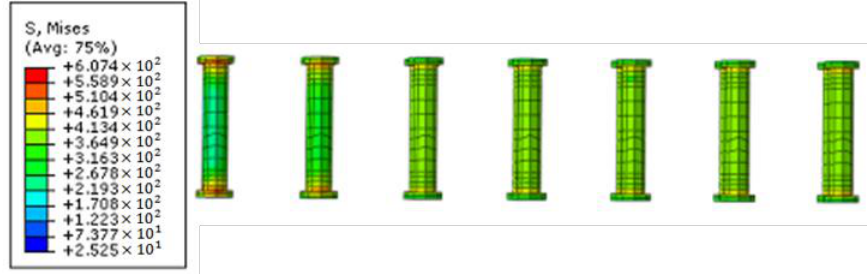
Figure 18. Stress cloud diagrams of the bolts.